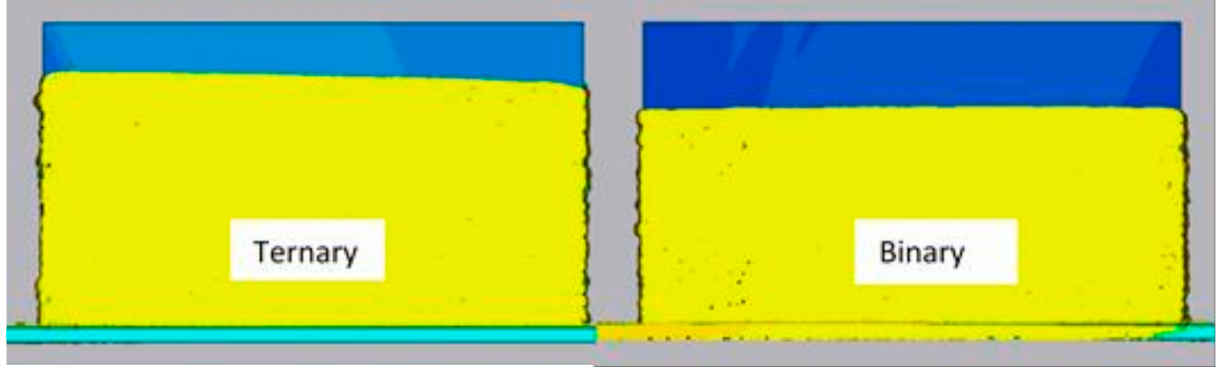
Figure 5. Comparison between CAD geometry (in blue) and scanned build part (in yellow) for the two gas blends.